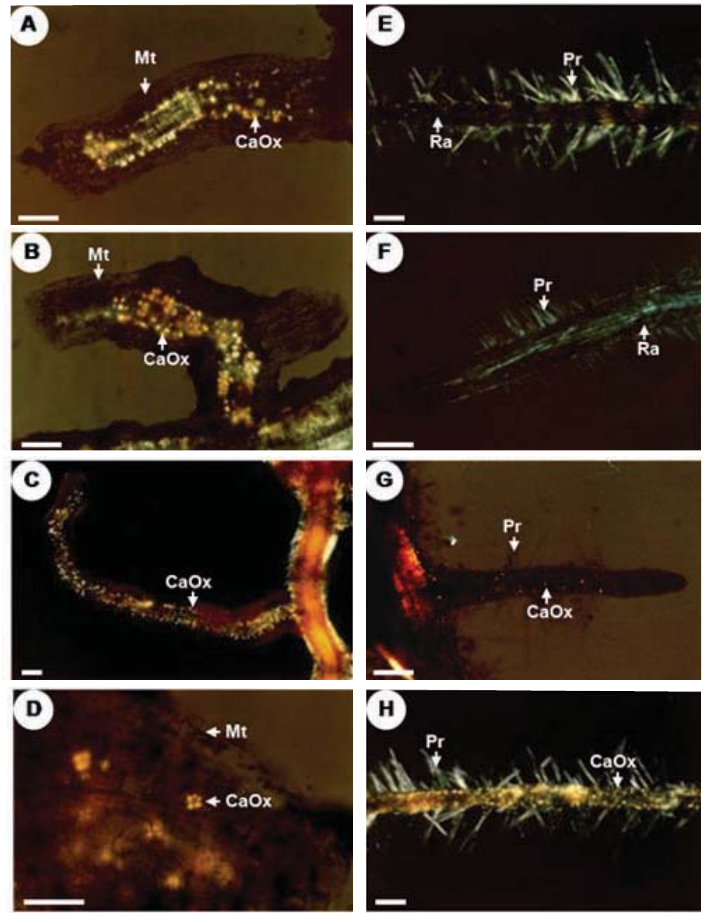
Figura 1. Ectomicorrizas (A-D) e raízes não micorrizadas (E-H) de híbrido de Eucalyptus grandis x Eucalyptus urophylla , coletadas em campo, submetidas à diafanização com hipoclorito de sódio a 1,8 % e observadas em microscópio óptico com luz polarizada para visualização de cristais de oxalato de Ca (CaOx). Os CaOx aparecem como pontos brilhantes nas estruturas diafanizadas. Observar os CaOx na forma de drusas (A, B, D) e CaOx do tipo granuloso (C, E, H). Manto micorrízico (Mt) e pelos radiculares (Pr) nas ectomicorrizas e raízes (Ra) do eucalipto, respectivamente. Barras: A, B, C, D = 50 μμμμμ m, E, F, G e H = 200 μμμμμ